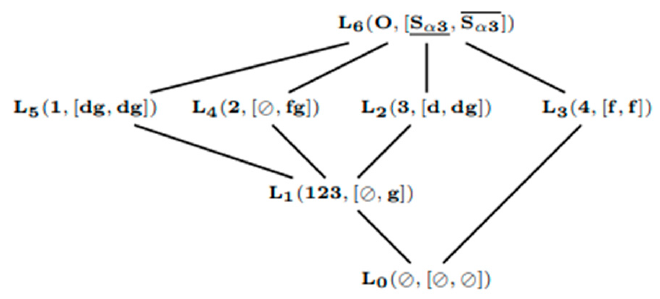
Figure 5. Reduct 𝑆 (cid:3080)(cid:2871) . Figure 5. Reduct S α 3 .